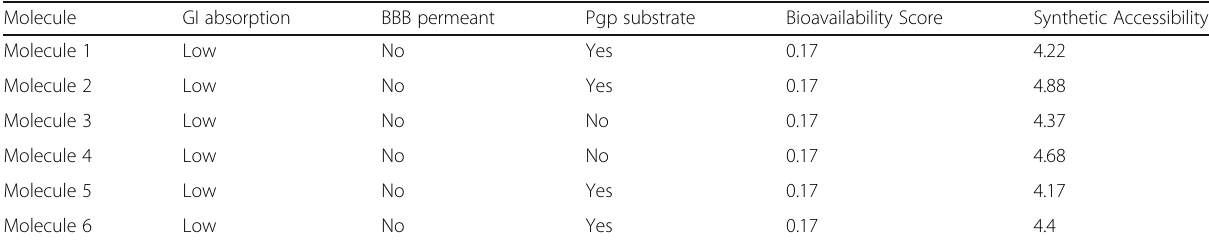
Table 8 ADME Properties of the designed compounds